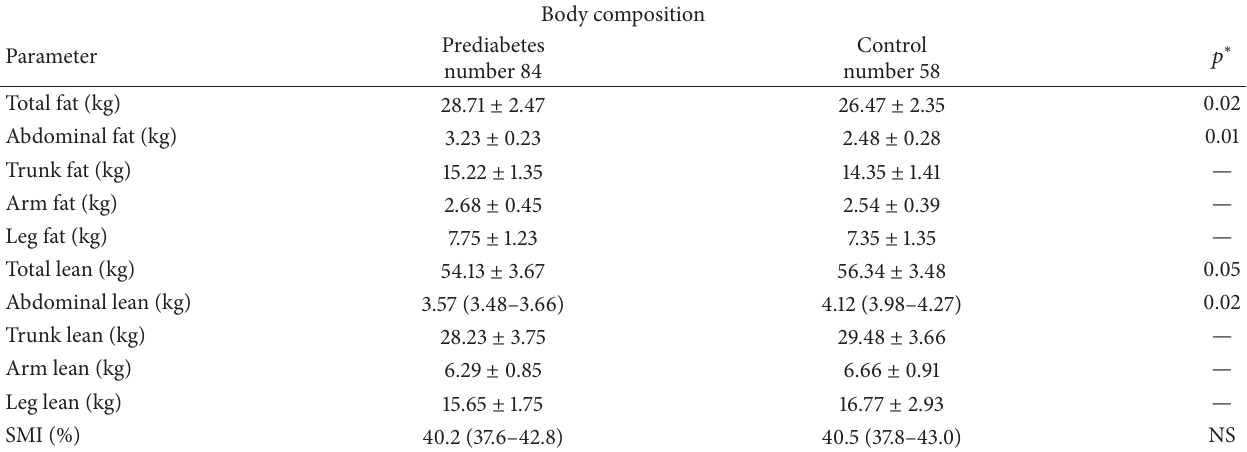
Table 3: Body composition and SMI assessed by DXA methods among patients with PD and control group.